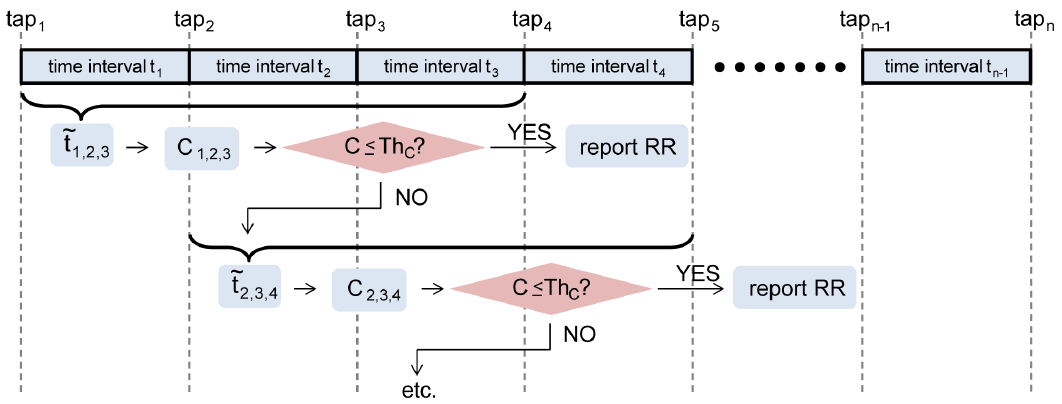
Figure 1. Estimation of respiratory rate (RR) with a set size of 3 tap time intervals. The median time interval ~ tt is calculated for the set and the consistency C is derived. RR is reported and the measurement stopped if C is below a specified consistency threshold Th C , otherwise tapping continues and a new set is created, until an acceptable C is obtained.